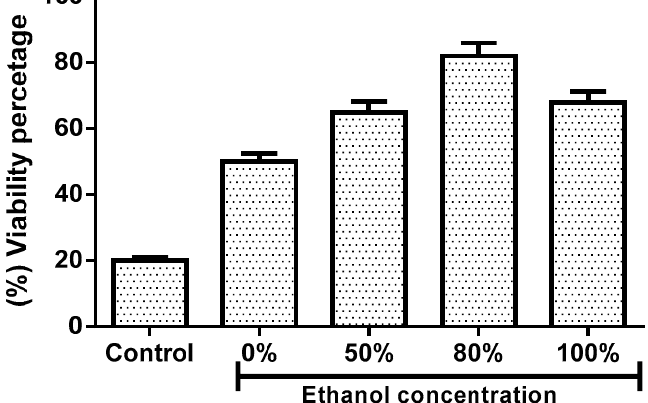
Figure 7. Extract ethanol concentration e ff ect on cell survival. Groups of cells were treated with 1 mM of H 2 O 2 to induce oxidative stress for 24 h at 37 ◦ C with 5% CO 2 . After this incubation, the cells were treated with 1 IC 50 individual extract ethanol of 0% (427.49 µ g / mL), 50% (275.41 µ g / mL), 80% (271.61 µ g / mL), and 100% (272.14 µ g / mL) and incubated for 24 h to determine the viability percentage as described in Materials and Methods. Each bar corresponds to the results (mean ± standard deviation (SD)) from three di ff erent preparations.